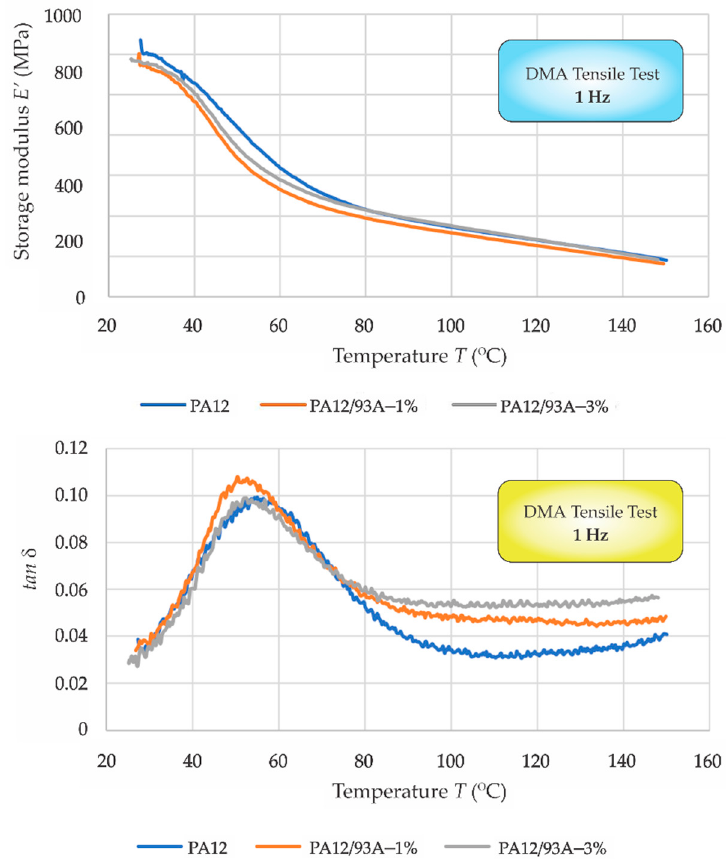
Figure 6. Dynamic mechanical analysis (DMA)—tensile 1 Hz: ( top ) storage modulus ( E’ ) versus temperature ( T ) and ( bottom ) tan δ versus temperature ( T ).